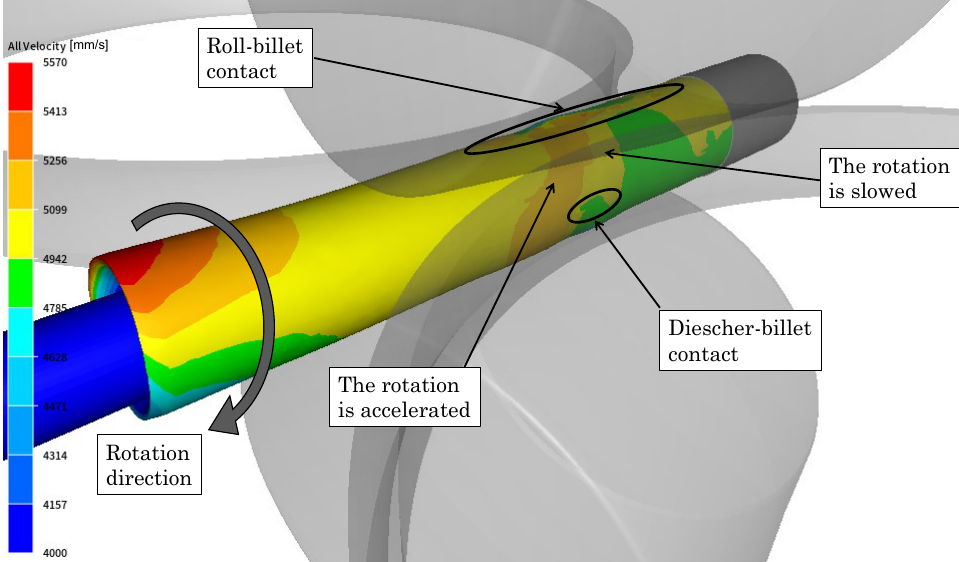
Figure 13. Absolute velocity